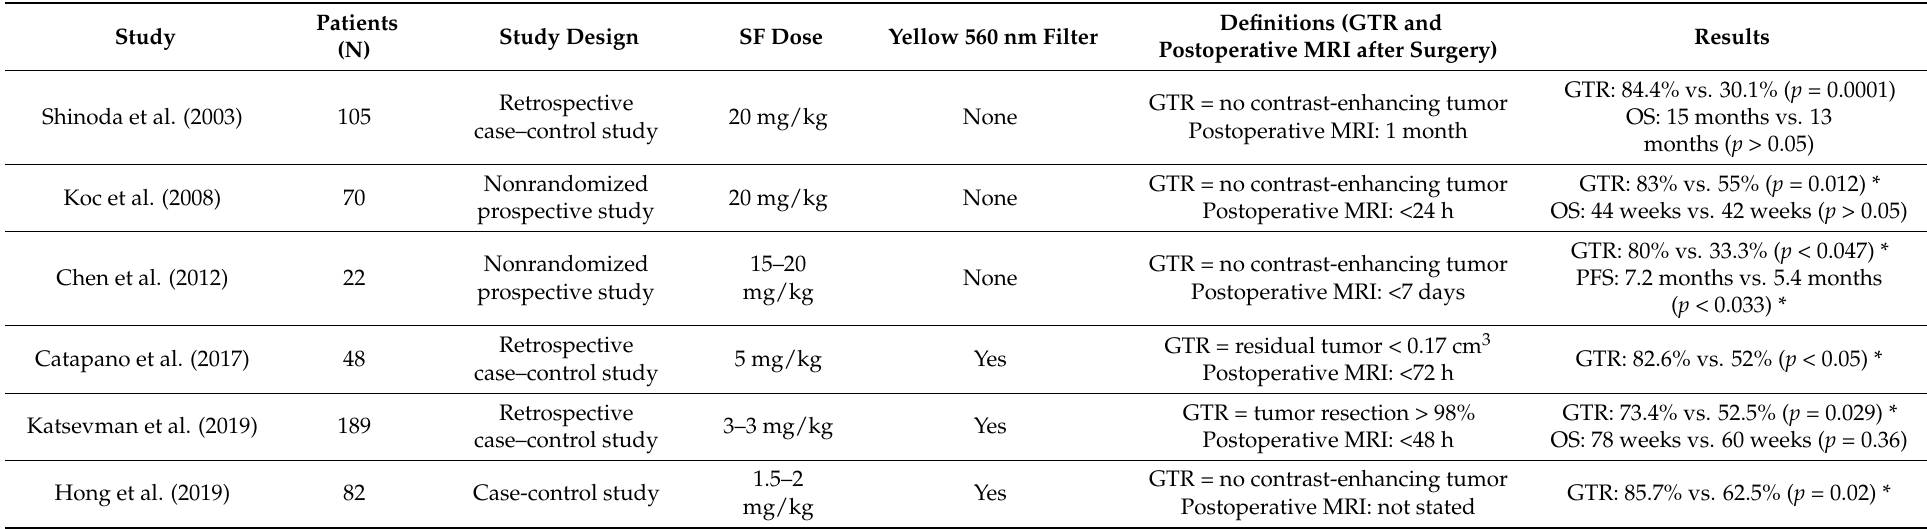
Table 2. HGG studies with SF-guided surgery compared to white light